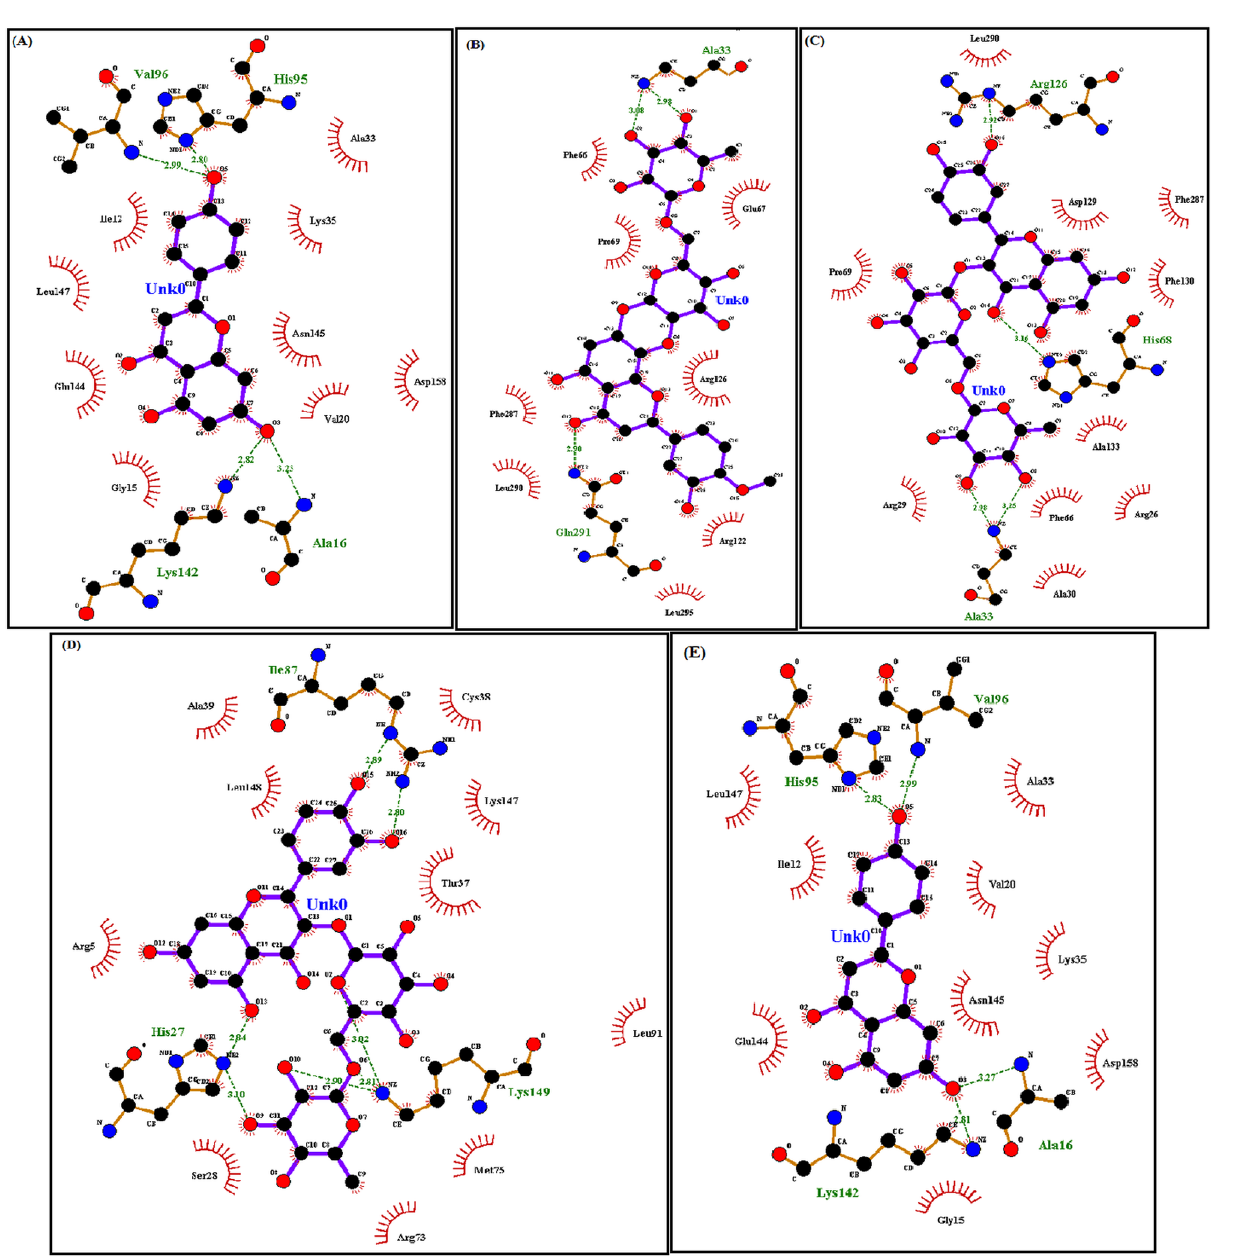
Fig 2. Ligplot analysis of CDK4 mutant proteins with virtual compounds. (A) Ligplot showing interaction between mutant type R24C and 5_7_DIHYDROXY_2_ (3_4_5_TRIHYDROXYPHENYL) _4H_CHROMEN_4_ONE. (B) Ligplot showing interaction between mutant model Y180H and Diosmin. (C) Ligplot showing interaction between mutant type A205T and Rutin. (D) Ligplot showing interaction between mutant type R210P and Rutin. (E) Ligplot showing interaction between mutant type R246C and 5_7_DIHYDROXY_2_ (3_4_5_TRIHYDROXYPHENYL) _4H_CHROMEN_4_ONE.